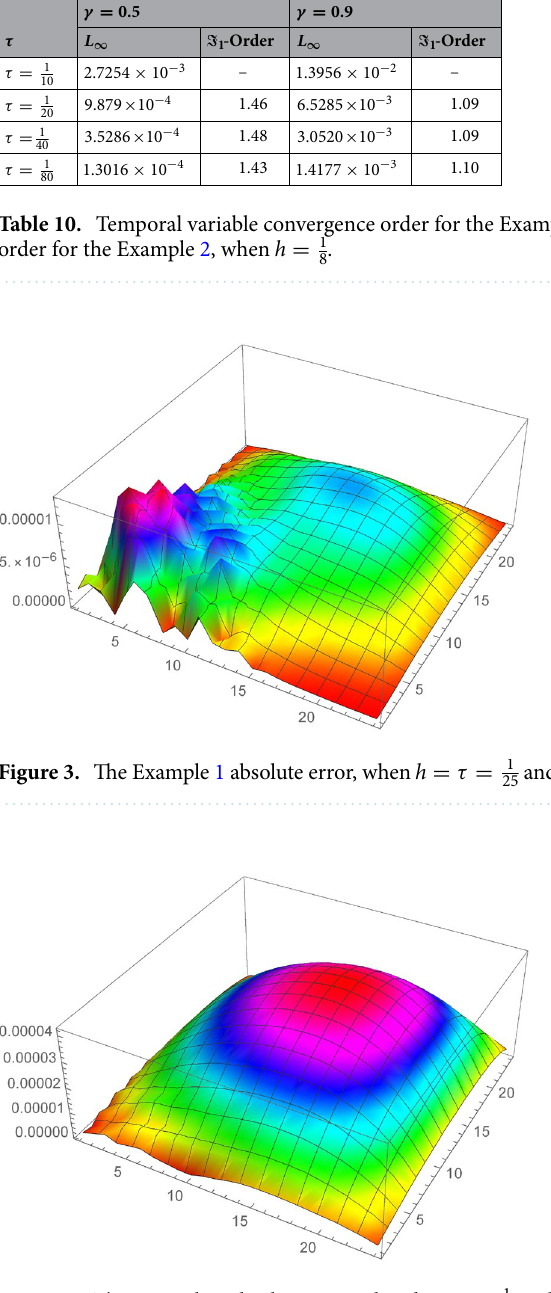
Figure 4. The Example 2 absolute error when h = τ = 1 25 and γ = 0.1